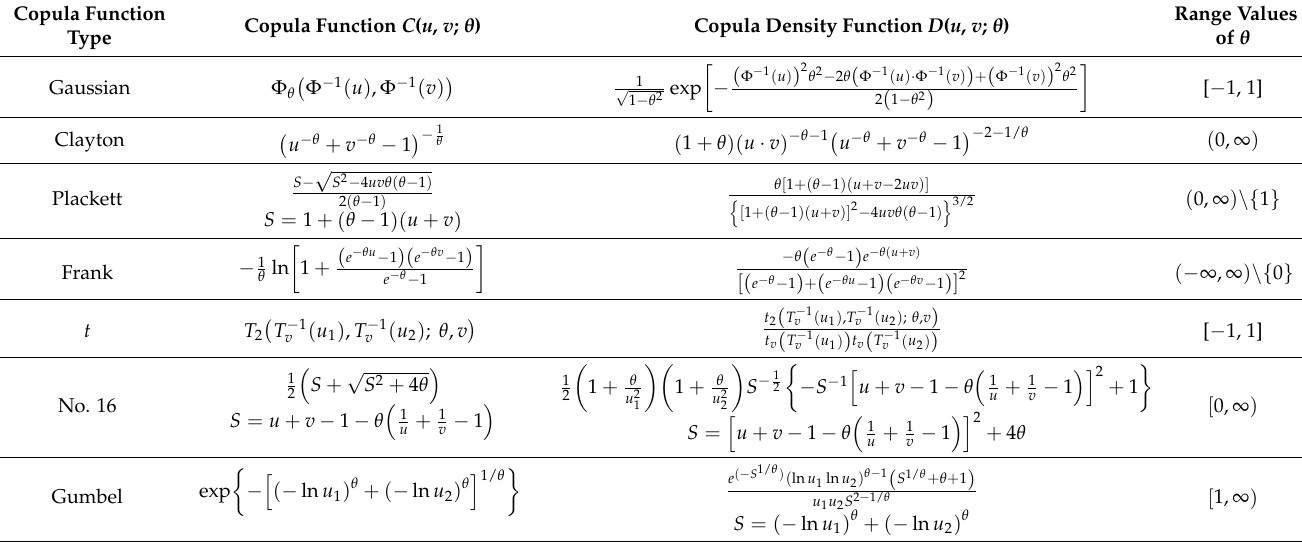
Table 1. Commonly used two-dimensional Copula